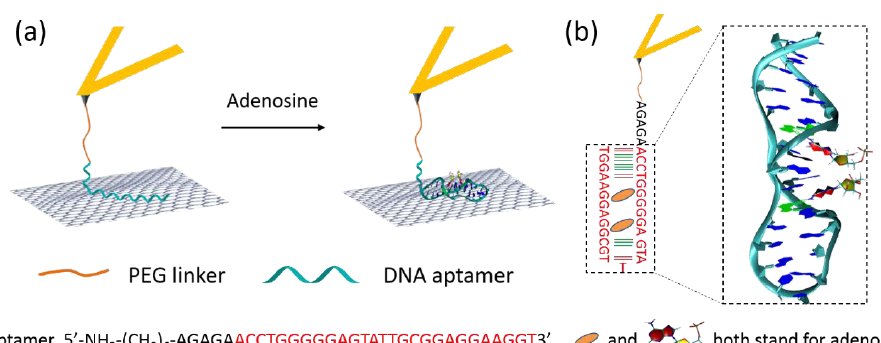
Figure 2. ( a ) Schematic representation of our AFM-based SMFS detection of adenosine. ( b ) Scheme and 3D structure of the adenosine/aptamer complex (PDB ID: 1AW4) [28].